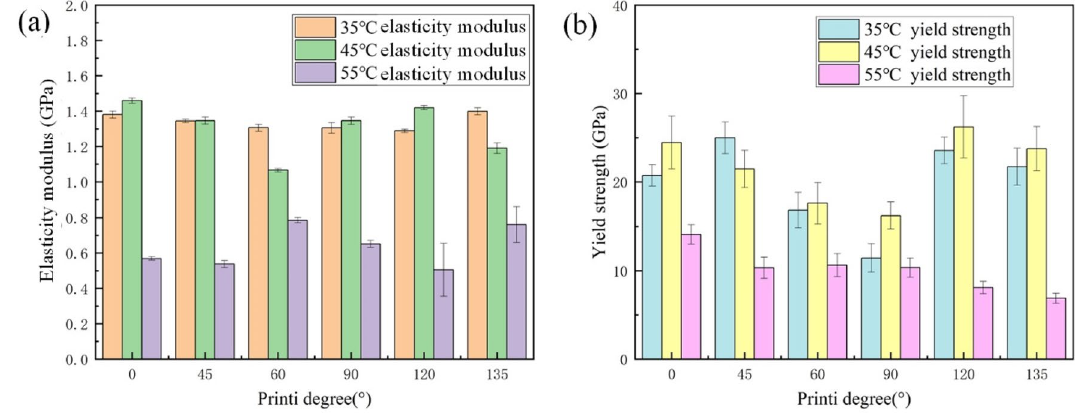
Figure 4. ( a ) Elasticity modulus for each temperature workpiece; and ( b ) yield strength of the workpiece at each temperature.